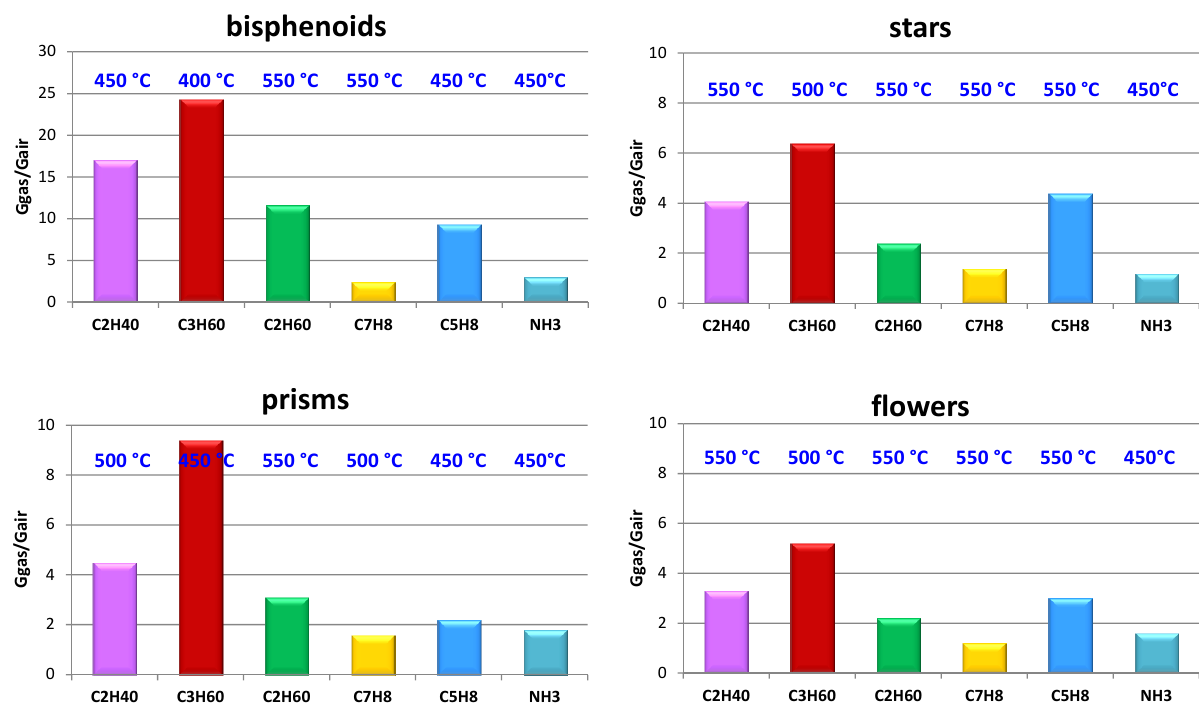
Figure 10. Responses toward 10 ppm of acetaldehyde, acetone, ethanol, toluene, isoprene, and ammonia in dry air for the sensors based on bisphenoids, stars, prisms, and flowers.